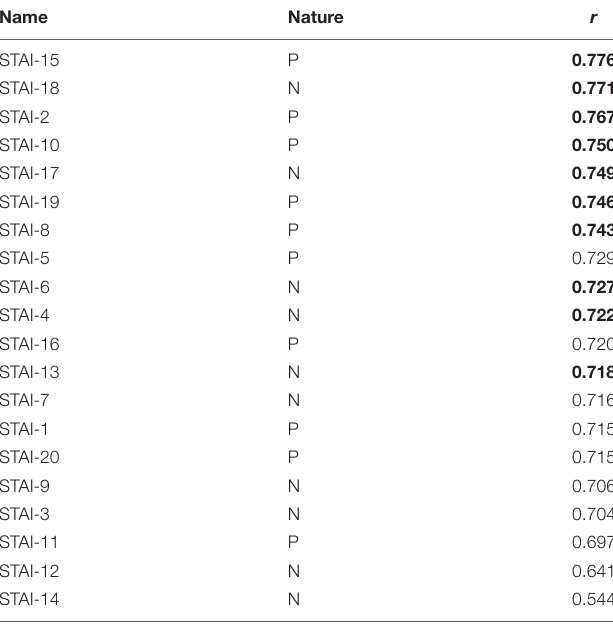
TABLE 2 | Corrected item-total correlations of the STAI-S scale ( n = 1142).